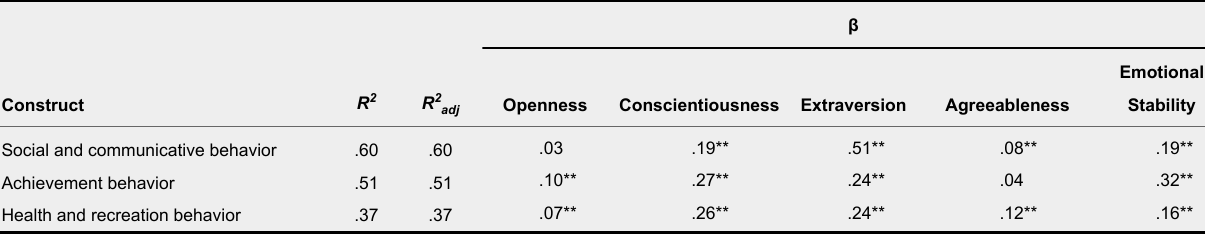
β Emotional Stability